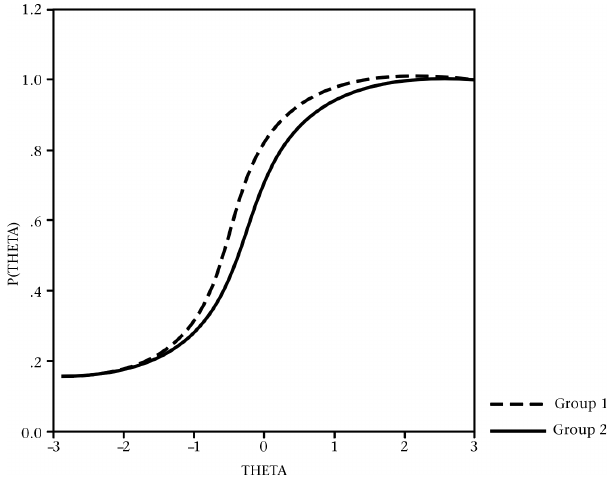
Figure 2: Item showing uniform DIF